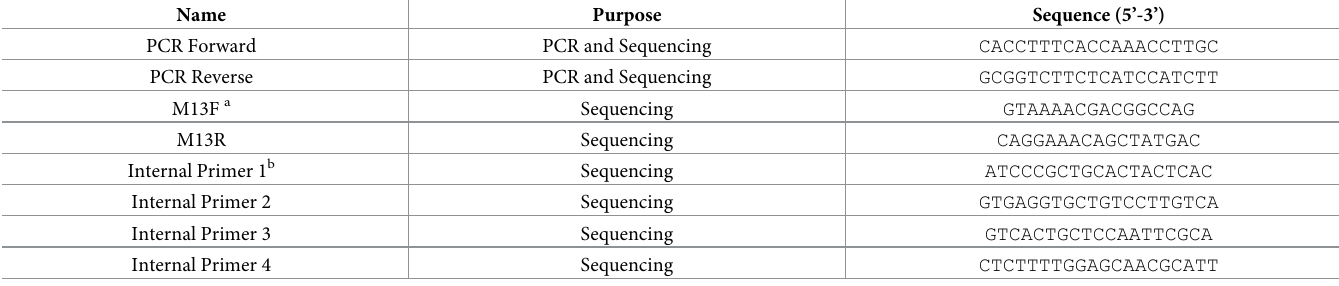
Table 1. Sequences of primers and internal primers designed for RT-PCR amplification and sequencing of PPX2 cDNAs from waterhemp.